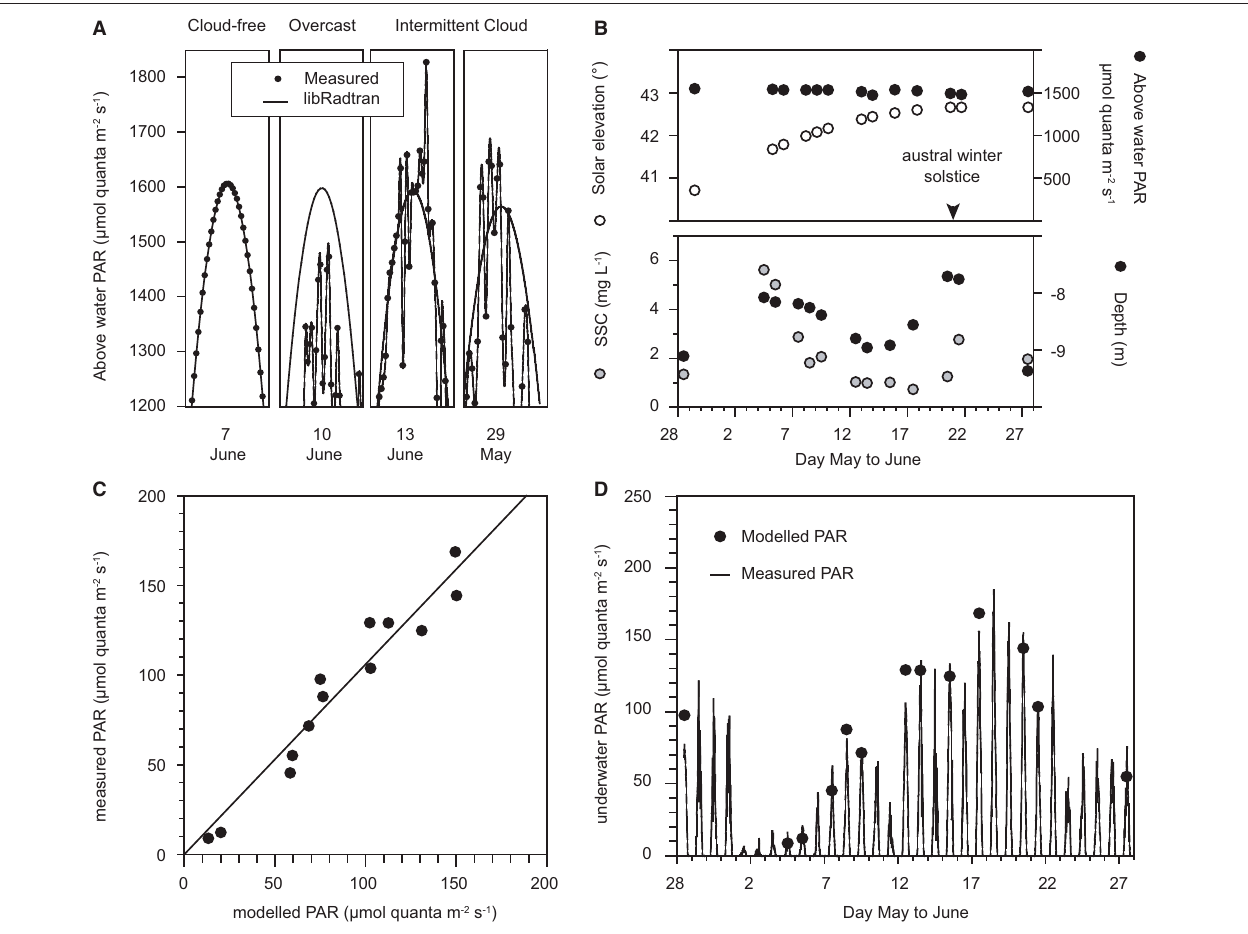
FIGURE 7 | (A) Representative examples of predicted surface light from the libRadtran radiative transfer model vs. measured surface light at + 10m elevation during cloud-free days, overcast days, and days with intermittent clouds, (B) Solar elevation ( ◦ ), above water ( + 10m) PAR, SSCs (mg L − 1 ), and water depth averaged over 12:00, 12:15, and 12:30 pm (local time) on cloud-free days from 28 May to 28 June 2017, (C) Calculated underwater PAR, using the empirical spectral Solar irradiance model vs. measured PAR over 12:00, 12:15, and 12:30 pm (local time) on cloud-free days, (D) modelled vs. measured underwater PAR at Florence Bay (8–9m) ( µ mol quanta m − 2 s − 1